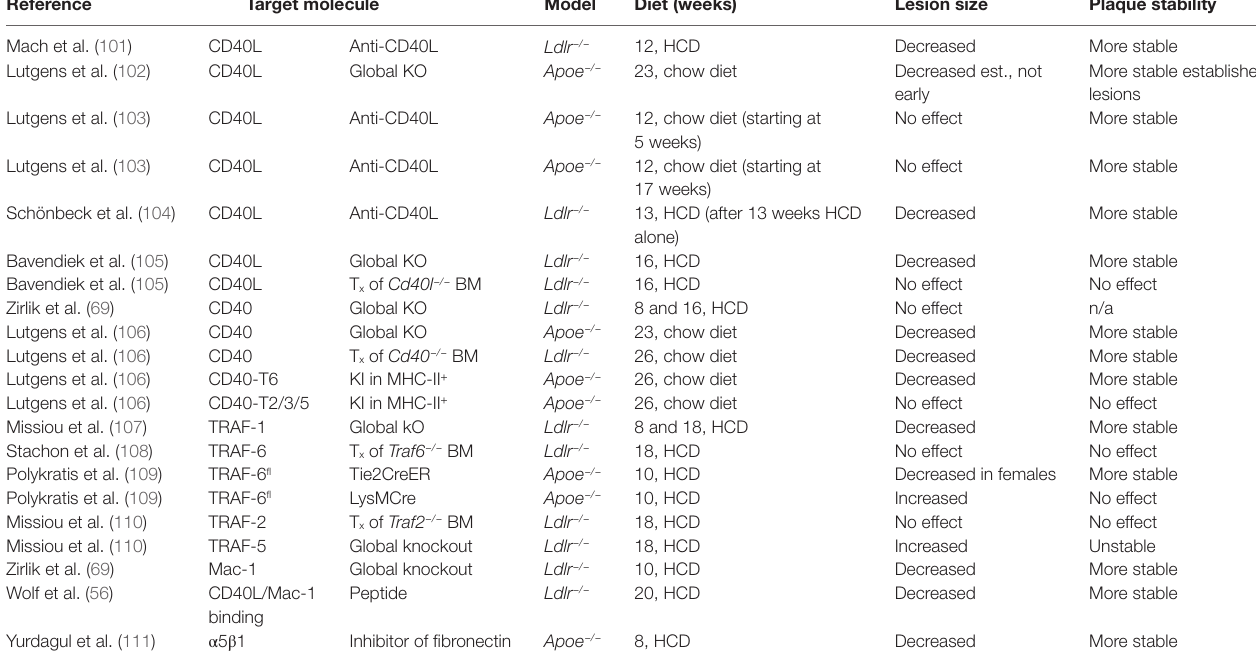
TABLe 2 | CD40L-associated molecules in experimental